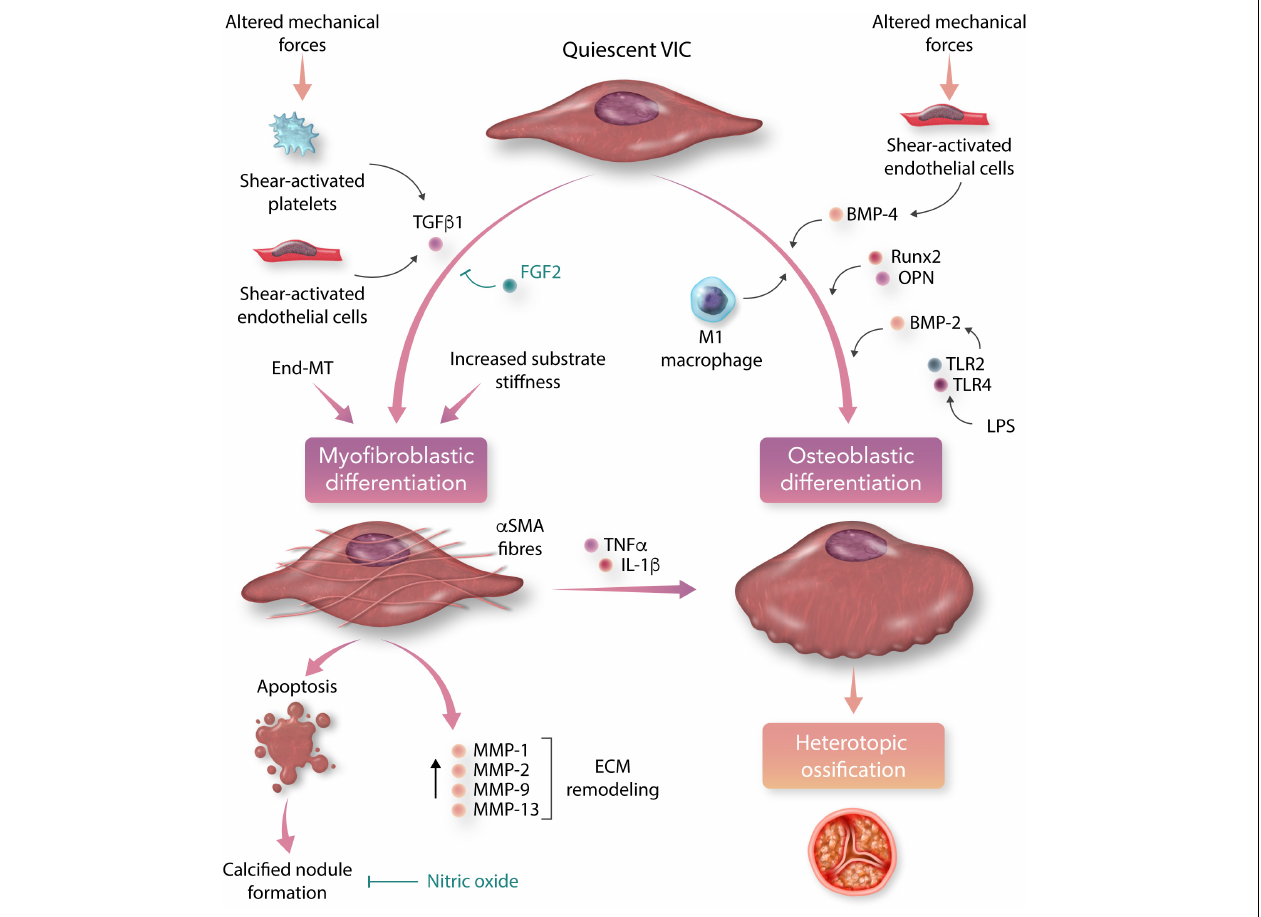
FIGURE 3 | Myofibroblastic and osteoblastic differentiation of aortic valvular interstitial cells (VICs) in calcific aortic valve disease (CAVD). Under the influence of circulating and local chemical stimuli, pluripotent valvular interstitial cells differentiate into myofibroblastic and osteoblastic phenotypes, which are the major cellular effectors of valve leaflet remodelling and calcification (TGF β 1, transforming growth factor beta-1; BMP, bone morphogenetic protein; OPN, osteopontin; TLR, toll-like receptor; LPS, lipopolysaccharide; End-MT, endothelial-to-mesenchymal transition; FGF2, fibroblast growth factor-2; α SMA, alpha-smooth muscle actin; TNF α , tumour necrosis factor-alpha; IL-1 β , interleukin 1-beta; MMP, matrix metalloprotein; ECM, extracellular